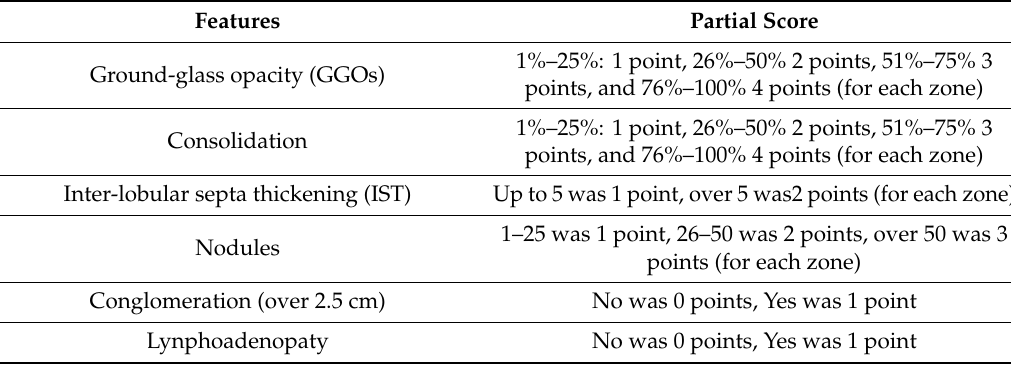
Table 2. Modified criteria adopted for the assignment of the computer tomography activity score (CTAS), from Duan